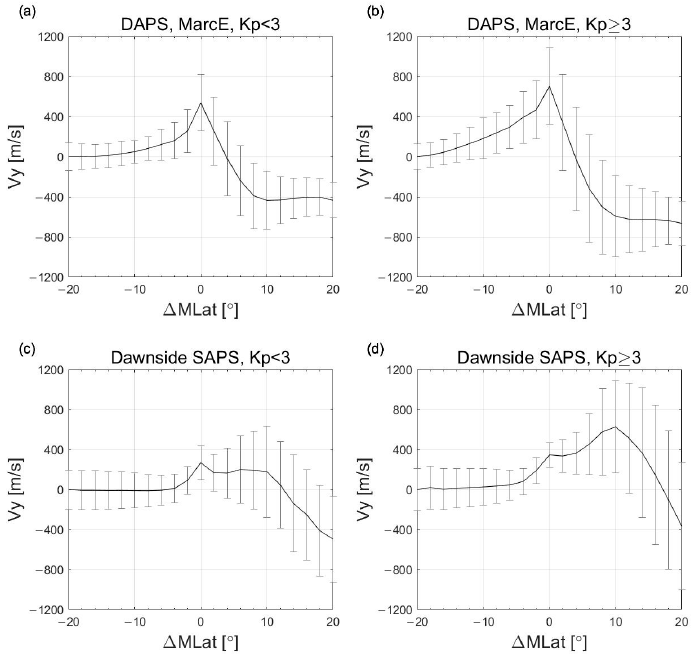
Figure 3. Superposed epoch analyses of the cross-track DAPS velocity Vy ( a , b ) at March equinox and dawnside SAPS velocity ( c , d ) without seasonal separation under different geomagnetic activity levels. The 0 key MLat denotes the latitude where the cross-track velocity (DAPS or SAPS) peaks. Positive values denote the eastward (i.e., sunward) direction. The bars show the standard deviations of 2° averages. Table 2. The mean velocities of the DAPS and dawnside SAPS at the latitudes where they peak under two different Kp levels. The abbreviation MarcE denotes the March equinox, JuneS denotes the June solstice, SeptE denotes the September equinox, and DeceS denotes the December solstice. Eastward Velocity, Vy (m/s) DAPS Dawnside SAPS Season MarcE